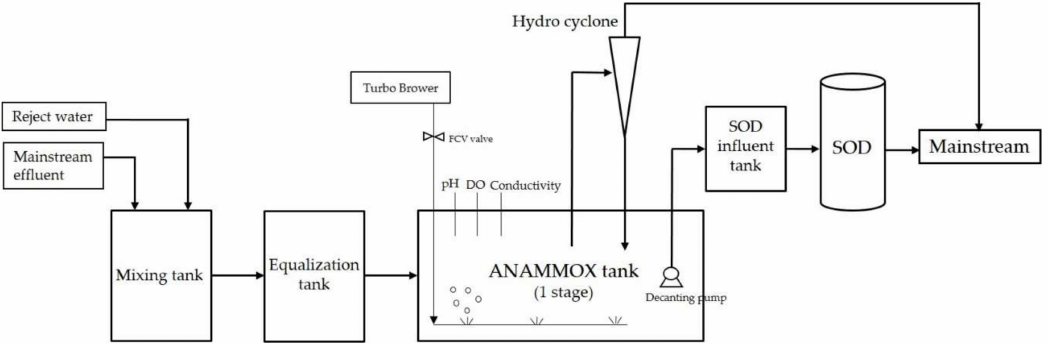
Figure 1. Process